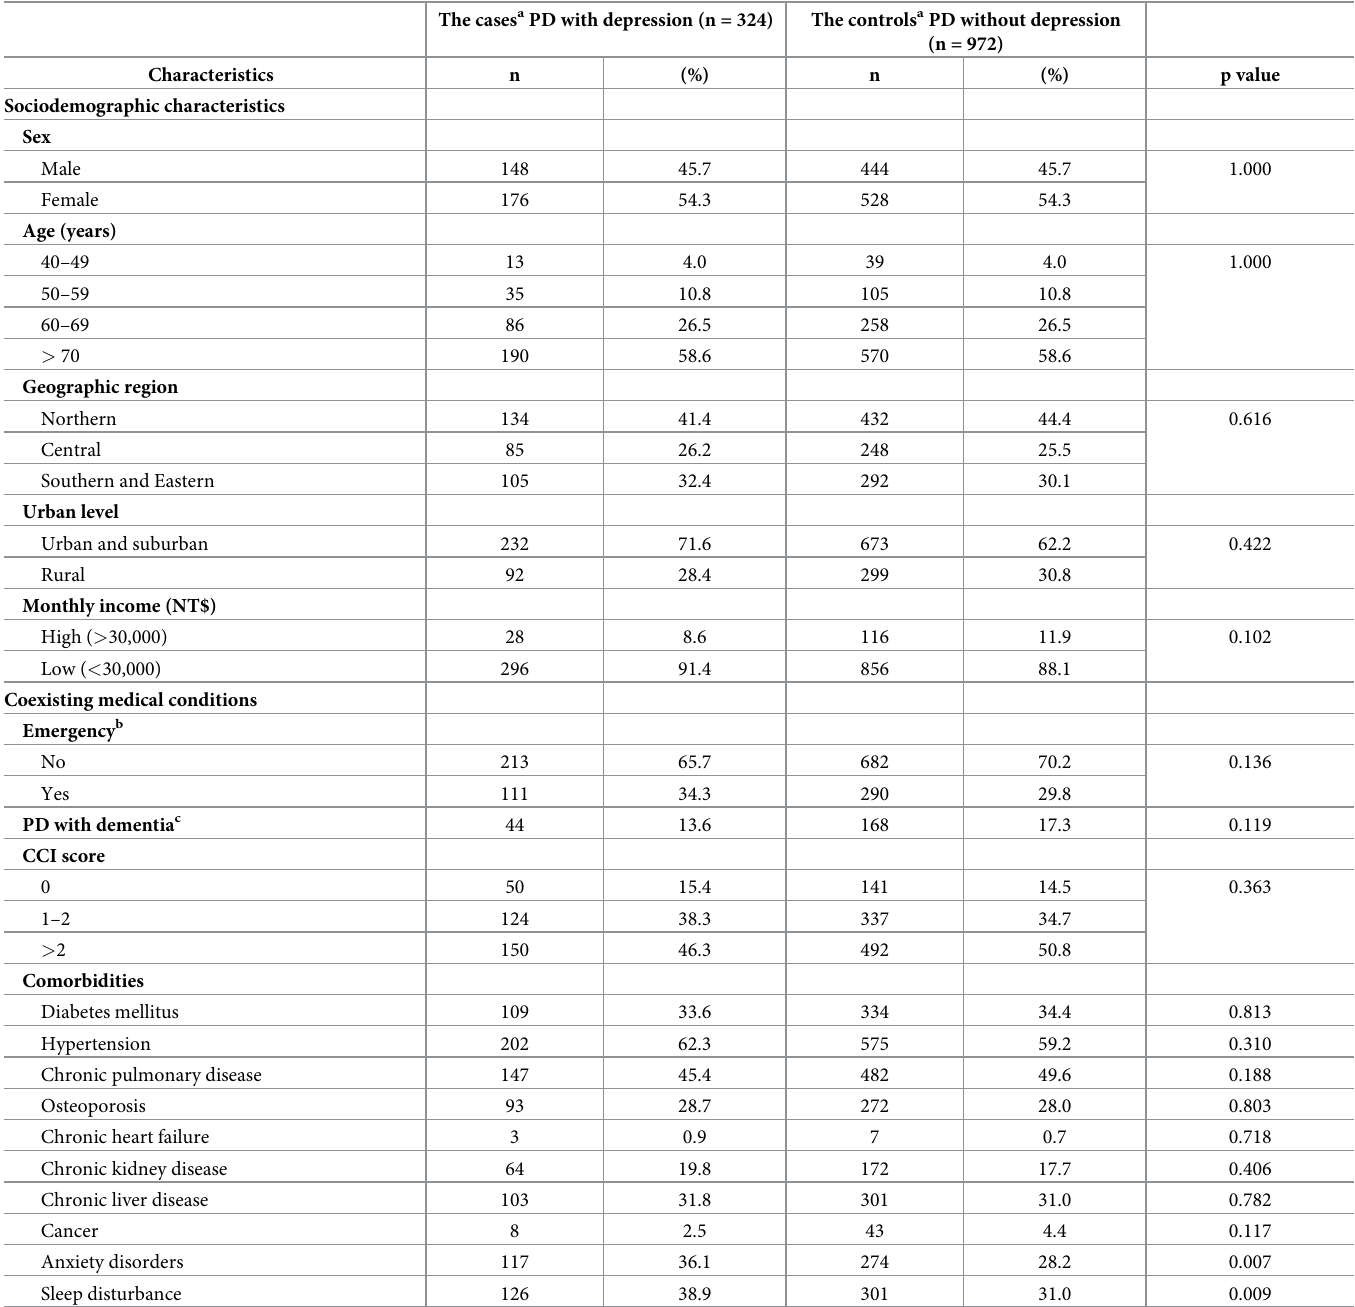
Table 1. Characteristics of Parkinson’s disease patients with depression (cases) and the controls. The cases a PD with depression (n =